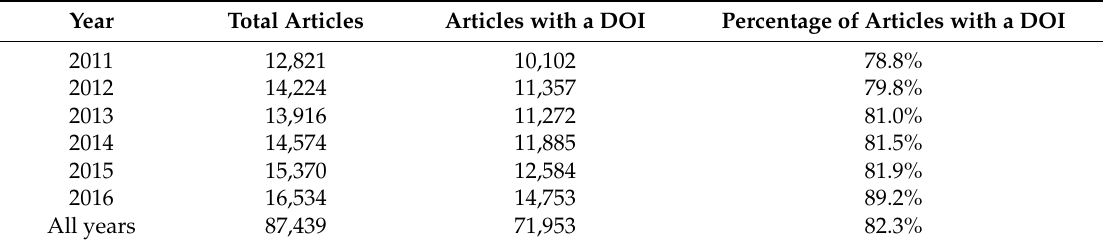
Table 1. Number of articles indexed in Cristin and number of articles with